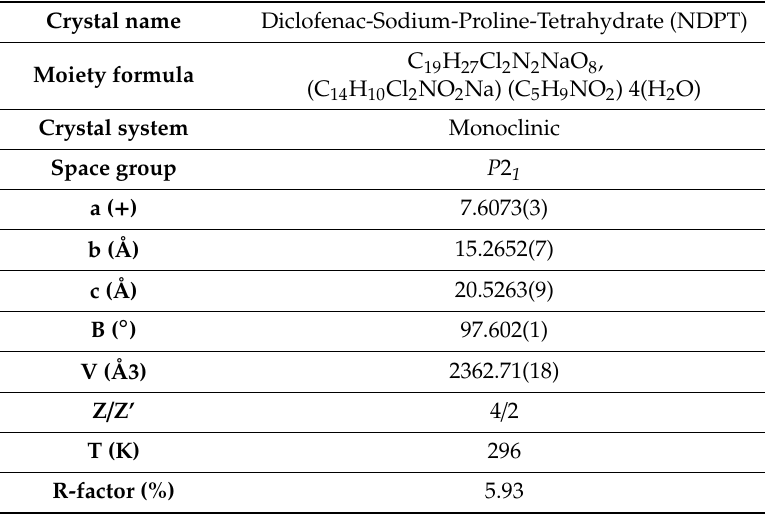
Table 1. Crystallographic data of